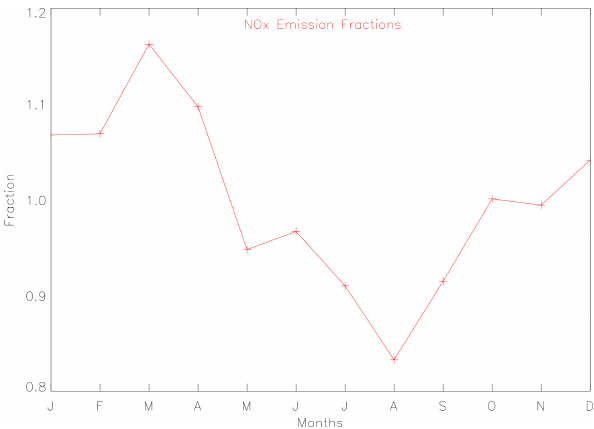
Figure 3. NO x emissions seasonal cycle, based on Visschedijk et al. (2007), which is applied to AQUM’s NO x emission annual totals.